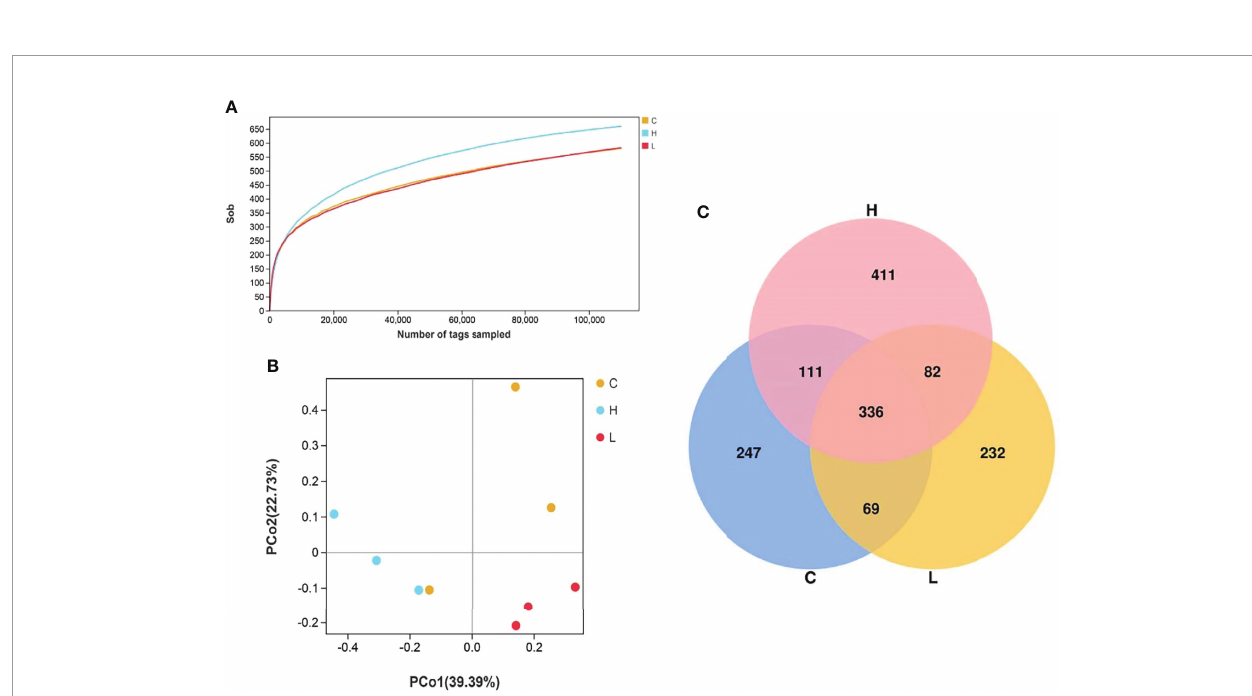
FIGURE 6 | Rarefaction curves of channel cat fi sh intestinal microbial samples (A) ; Principal component analysis of samples from two groups (B) , n = 3; Venn diagram of the OTU distribution (C) . C: 0 m g/L Del; L: 0.5 m g/L Del; H: 5 m g/L Del.